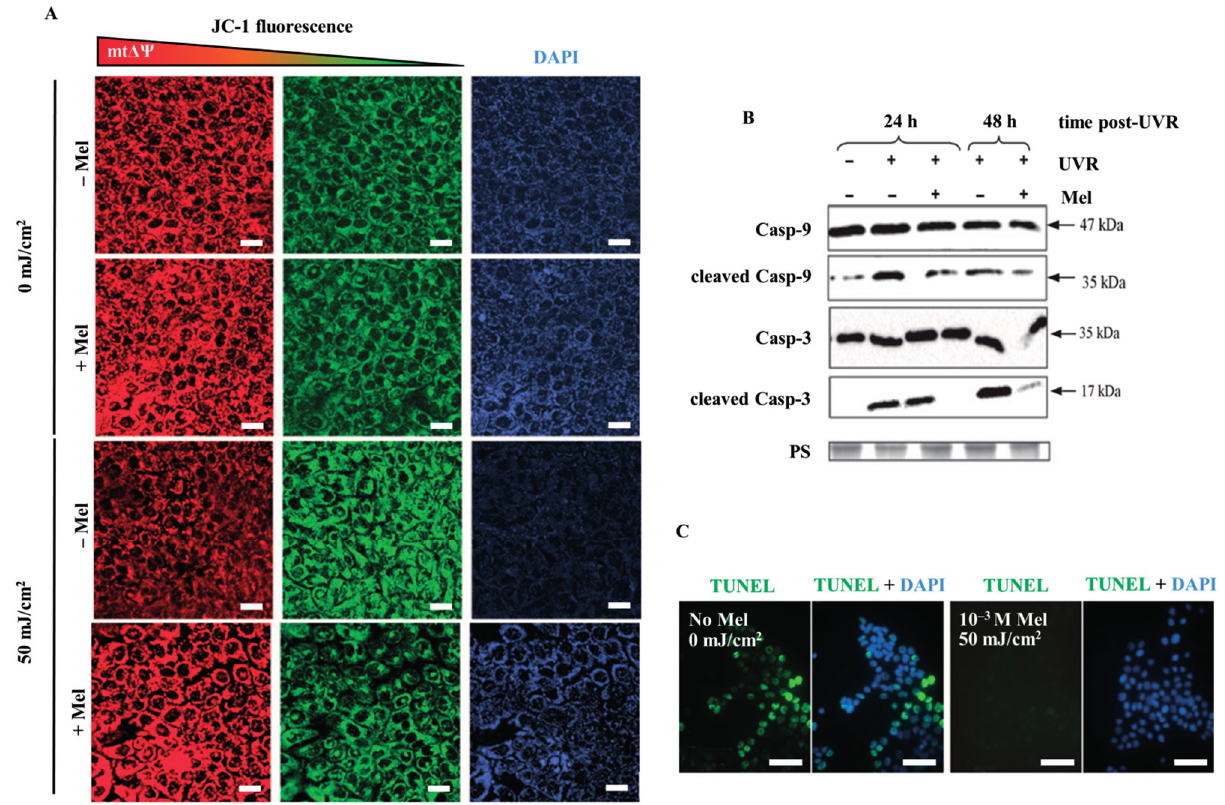
Figure 6. UVR-induced changes in mitochondrial transmembrane potential and protective action of melatonin ( A ) in HaCaT keratinocytes. Cells were pre-incubated with melatonin (10 − 4 M) and irradiated with the dose of 50 mJ/cm 2 . Mitochondrial membrane potential is indicated by JC-1 red fluorescence ( left panels). Relative changes in mitochondrial membrane potential are expressed as shifts from red to green fluorescence ( middle panels) and presented as the red to green ratio that produces blue fluorescence ( right panel); ( B ) Subsequent analysis of activation of mitochondrial-dependent (intrinsic) activation of cascade of caspases 3 and 9 showed prominent cleavage of both proteins leading to increased number of apoptotic TUNEL positive cells (green) indicating on UVR-mediated DNA damage ( C ) Bars = 20 μ m (magnification, 40×). Melatonin effectively protected the cells against these disturbances (modified after Fischer et al. [121] with permission from the